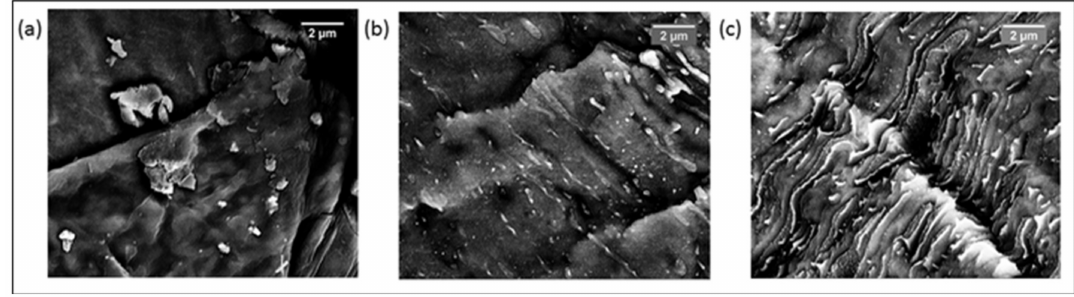
Figure 4. SEM images at 20 k magnification of ( a ) SEBS-10PS ( b ) SEBS-30PS and ( c ) SEBS-50PS specimens cryo-fractured along the direction of